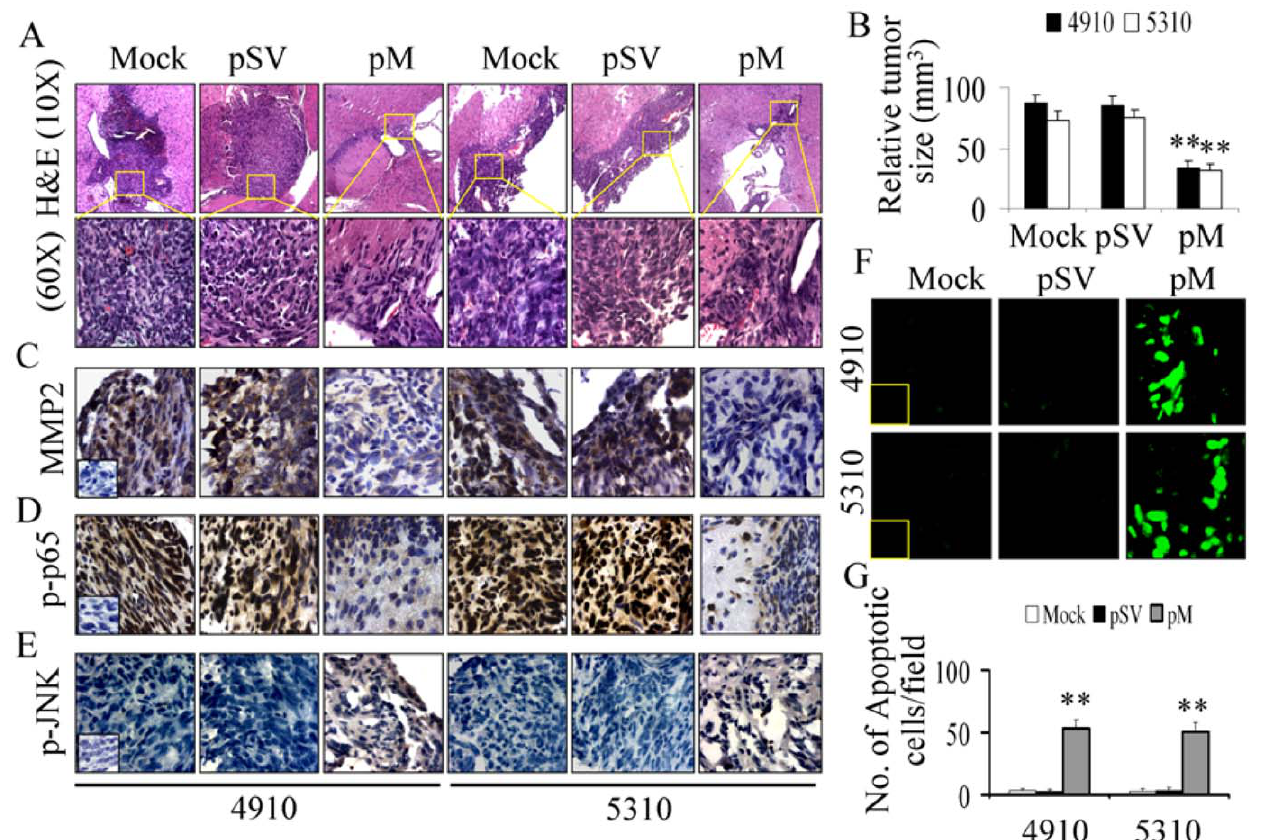
Figure 8. Tumorigenicity invivo in nude mice (nu/nu) brains induced by intracranial injection of 4910 and 5310 cells. The pSV and pM plasmids were injected into the tumors as described in Materials and Methods while the 1 6 PBS injection served as the mock control treatment. At the end of the experiment the brains were removed and fixed in 10% phosphate-buffered formaldehyde and the fixed tissue samples were subsequently embedded in paraffin blocks. A. Hematoxylin and Eosin staining of brain sections displaying the neoplastic growth of tumors after injections of 4910 and 5310 cells (10 6 and 60 6 ). B. The tumor area from every fifth H&E stained tumor section was calculated with the aid of microscope attached computer screen and Image Pro Discovery Program software (Media Cybernatics, Inc., Sliver spring, MD). The total tumor volume is calculated as summed area of tumor on all sections multiplied by width of the sections. The relative brain tumor size was estimated from mock-pSV and pM treated animals and plotted as mean 6 SE obtained from a group of 10 animals. The significant difference among different treatment groups was represented by ‘‘**’’, at p , 0.01. C. Immunohistochemical analyses through DAB staining were performed to detect the expression of MMP-2 in paraformaldehyde embedded tumor sections. Hematoxylin was used for nuclear counter staining and rabbit IgG was used as a negative control. D, E. Immunohistochemical studies showing the expression of phospho-p65 and phospho-JNK in mock, pSV, pM treated tumor sections. Hematoxylin was used for nuclear counter-staining and rabbit IgG was used a negative control. F. Examination of in situ cell death by TUNEL assay of brain tumor cells after treatments. Rabbit IgG was used as a negative control. G. Total number of apoptotic cells was counted in randomly selected microscopic fields and plotted in bar diagram with mean 6 SE and significant difference among treatment groups was represented by ‘‘**’’, at p , 0.01.